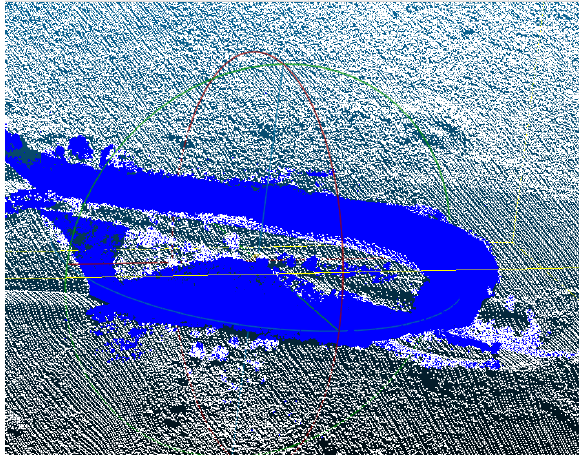
Figure 6. Terrestrial (blue) and aerial (white) mobile LiDAR point clouds registered in one